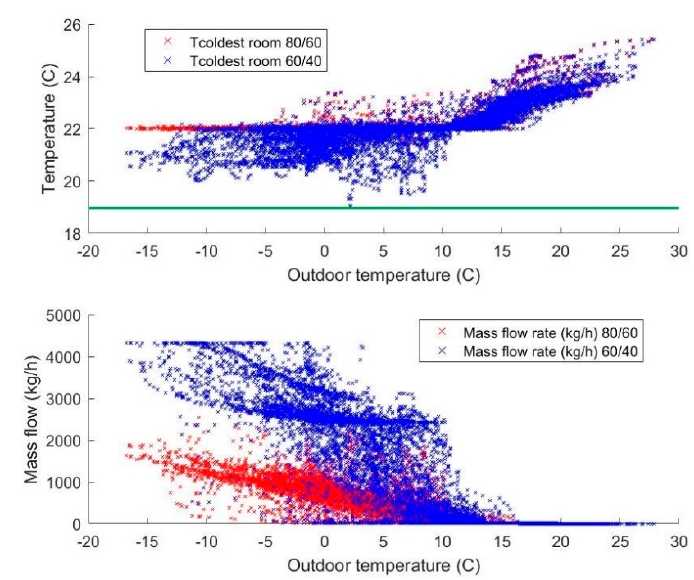
Figure 4. Temperature in the coldest room ( top ) and mass flow rates ( bottom ) relative to the outdoor temperature for AB_03 as-built.